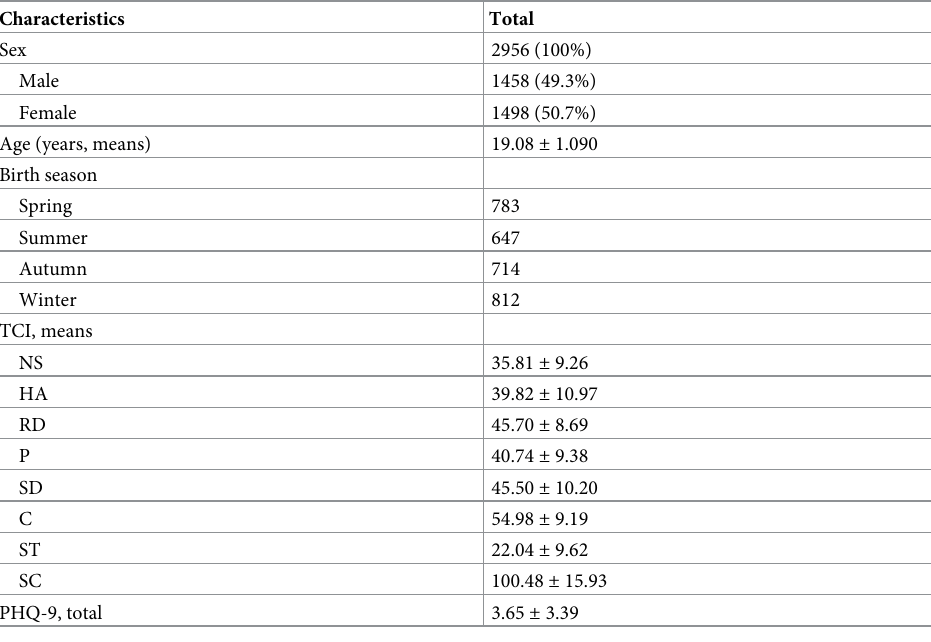
Table 1. General characteristics and research variables of the subjects (n = 2956).